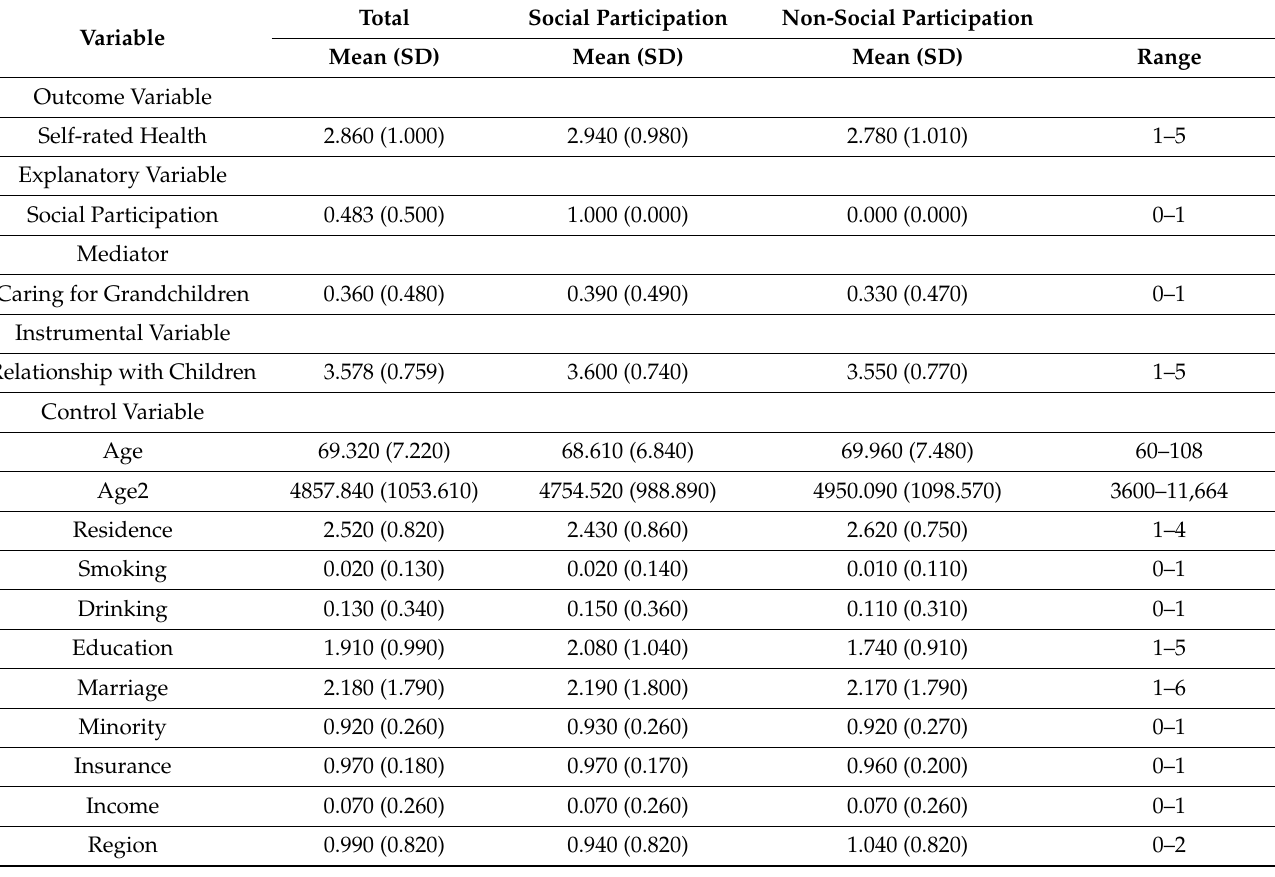
Table 2. Sample characteristics ( N =